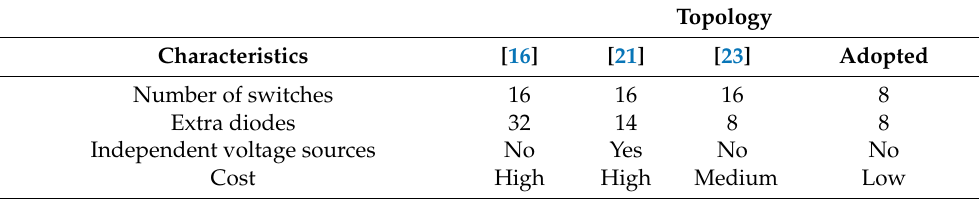
Table 2. Comparison with typical multilevel power converters used in SRM drives.